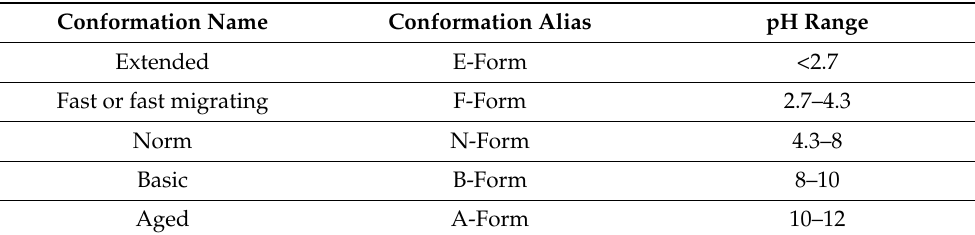
Table 1. HSA conformational transitions as the pH is varied [41,42].